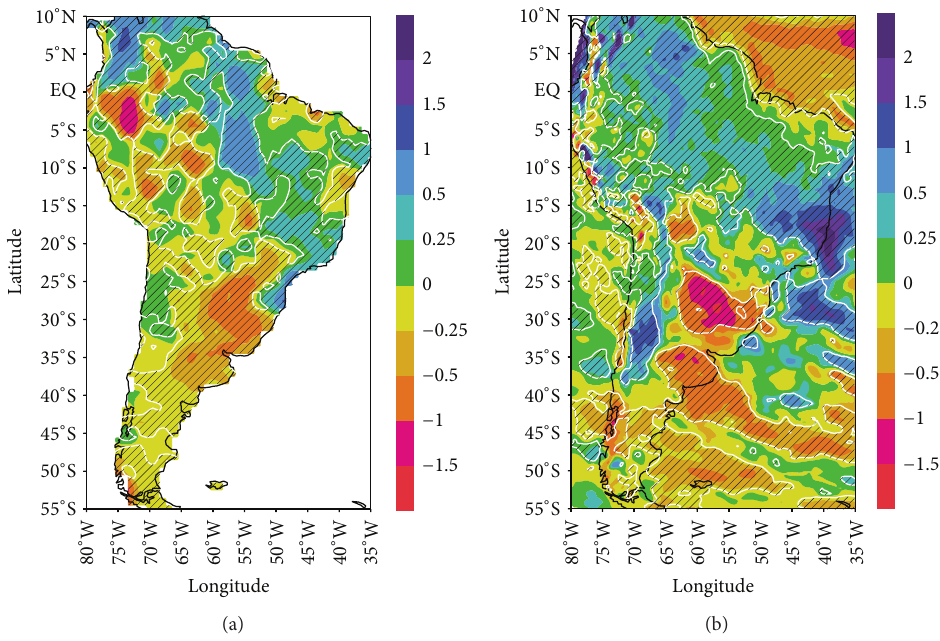
Figure 13: Precipitation anomaly (mmday −1 ) for HCSA strong cases in the period 1996–2011 based on the (a) GPCC dataset and (b) RegCM4 simulation. Contour intervals are 0.25 mmday −1 with hatching indicating regions statistically significant above the 95% confidence level as determined by two-tailed Student’s 𝑡